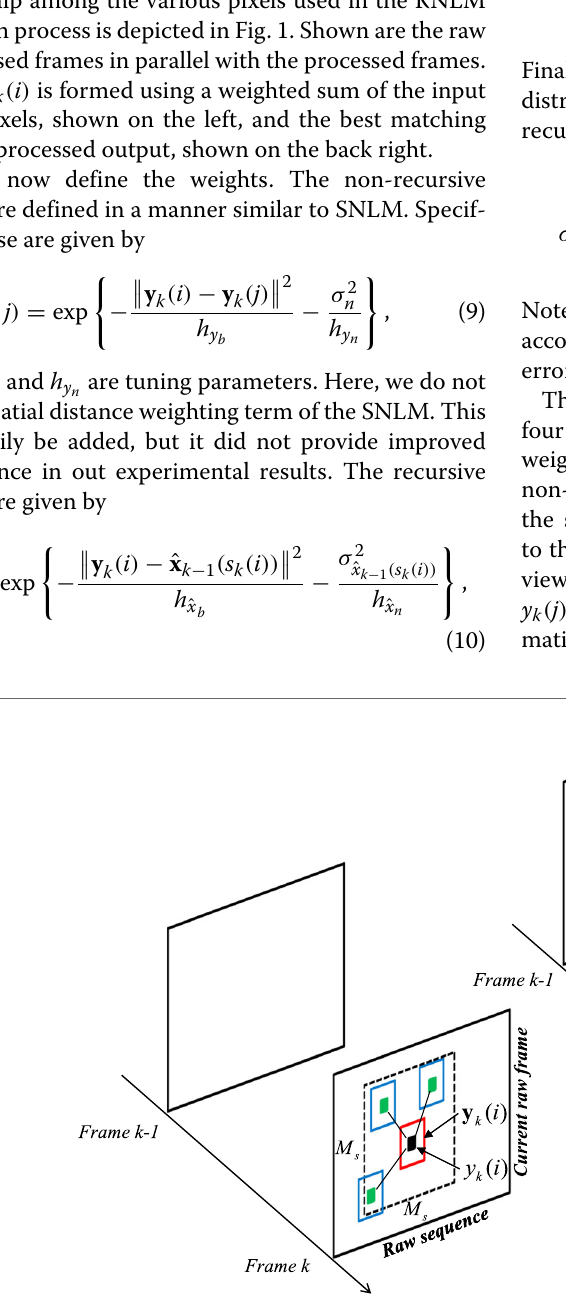
Fig. 1 Block diagram showing the pixels in the video sequence used in proposed RNLM algorithm. The leftside shows the raw input frames, and the rightside shows the processed frames. Because of the recursive processing, samples from the both input and processed frames are used to form the current